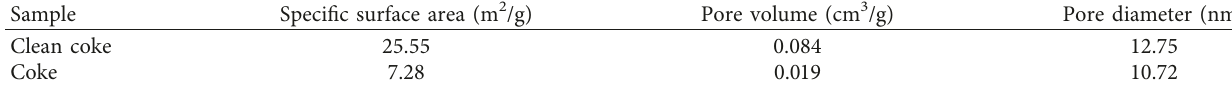
Table 6: Comparison of the surface area and porosity of the clean coke and the coke from the metallurgy samples. Sample